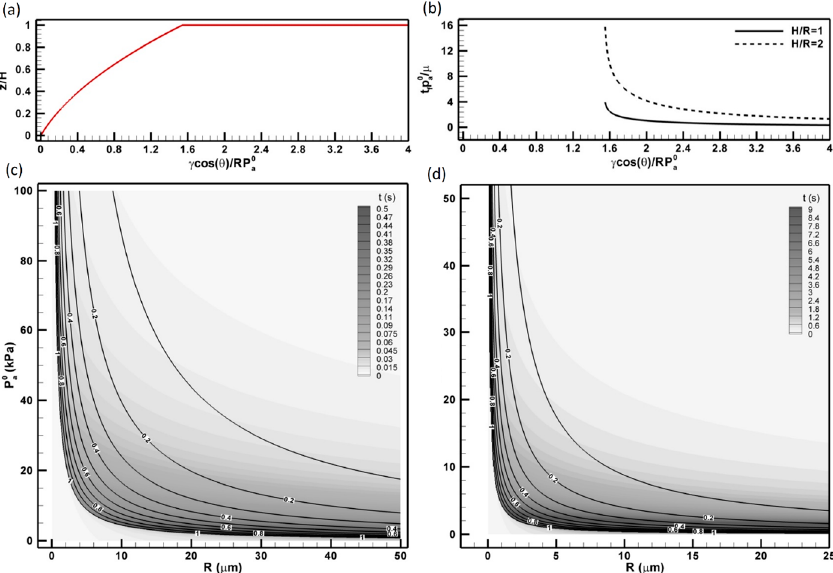
Figure 4. Modeling and characteristics of polymeric and plastic materials infiltrating a nano-pore. ( a ) normalized infiltration depth ( 𝑧/𝐻 ) vs the normalized capillary stresses ( 𝛾 cos𝜃 /𝑅𝑝 (cid:3028)(cid:2868) ), ( b ) infiltration time ( 𝑡 (cid:3033) ) normalized by that of pressure-driven infiltration ( 𝜇/𝑝 (cid:3028)(cid:2868) ) vs 𝛾 cos𝜃 /𝑅𝑝 (cid:3028)(cid:2868) . Fabrication parameters, 𝑧/𝐻 (line contours) and 𝑡 (cid:3033) 𝑝 (cid:3028)(cid:2868) /𝜇 (flood contours) for ( c ) polydimethylsiloxane (cross-linking polymer) and ( d ) polytetrafluoroethylene (thermoplastics) with respect to initial pressure, 𝑝 (cid:3028)(cid:2868) , and pore size, 𝑅 . Properties of polydimethylsiloxane (PDMS) and polytetrafluoroethylene (PTFE) are listed in Table A2.